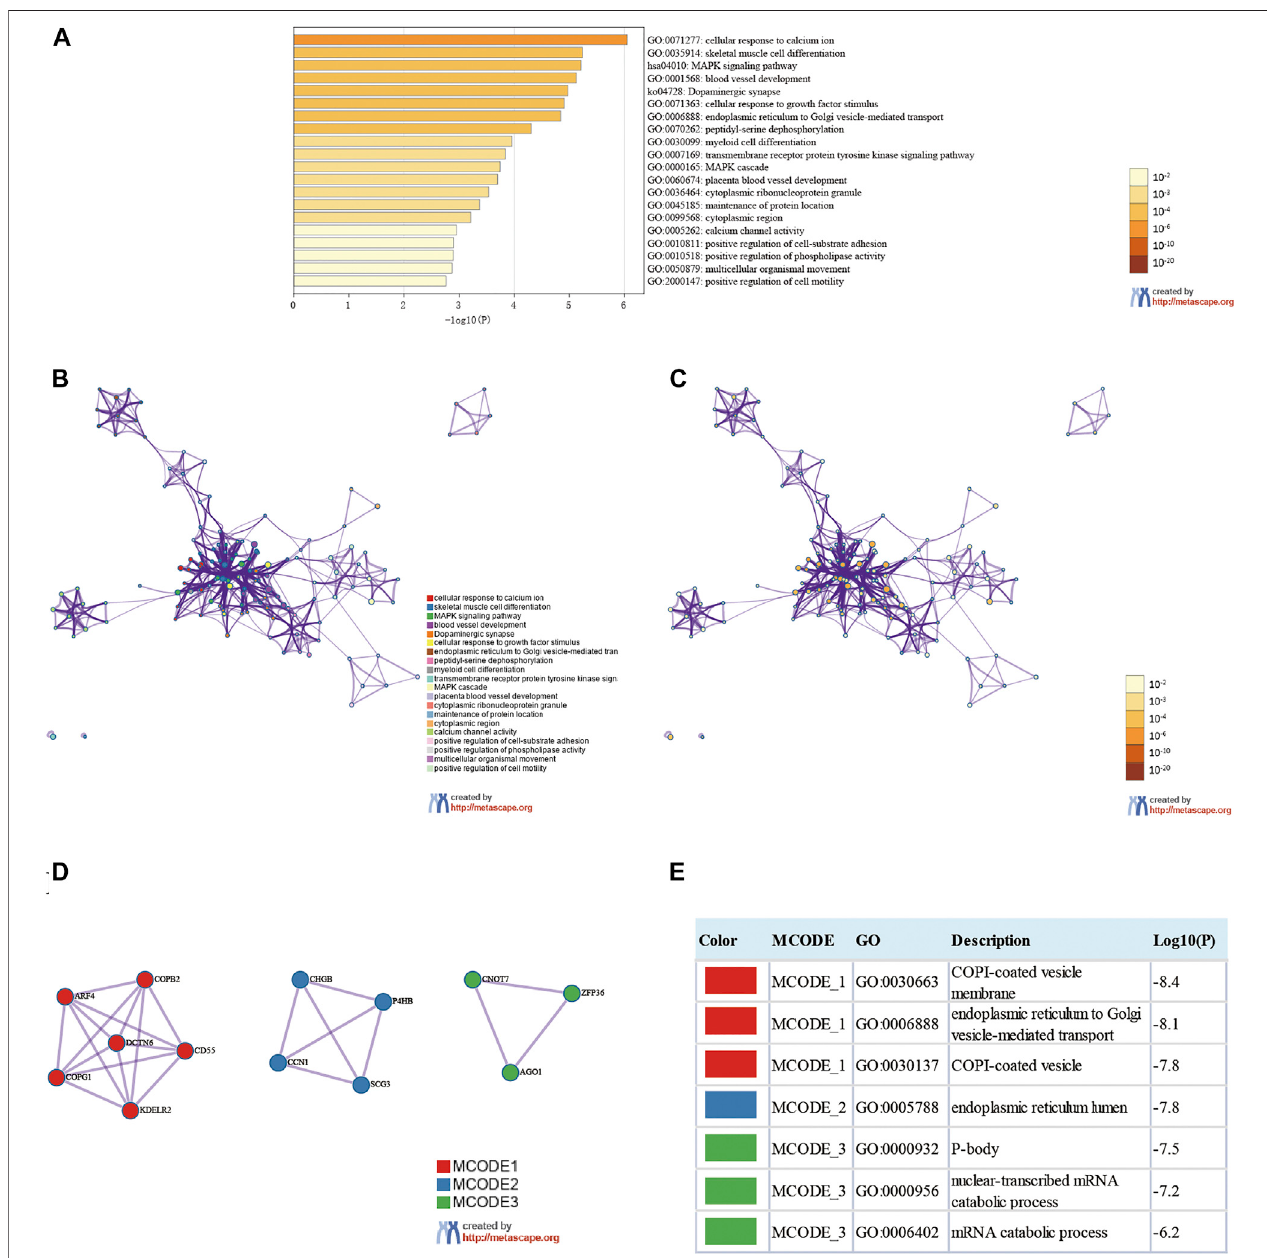
FIGURE10| Enrichmentanalysisofgenesrelatedto11-DMGmutationingastriccancer(GC)(Metascape). (A) HeatmapsofGoandKEGGenrichmentanalysisof 108 adjacent genes related to 11-DMG mutation were stained with p -value. (B) Term-enriched network: colored by cluster ID, where nodes sharing the same cluster ID areusuallyclosetoeachother, (C) coloredby p -value,termscontainingmoregenestendtohavemoresigni fi cant p -values. (D) FortheMCODEcomponentsidenti fi edin the protein-protein interaction network, (E) the three best score items divided by p -value are used as the functional description of the corresponding components, which are represented by the grid